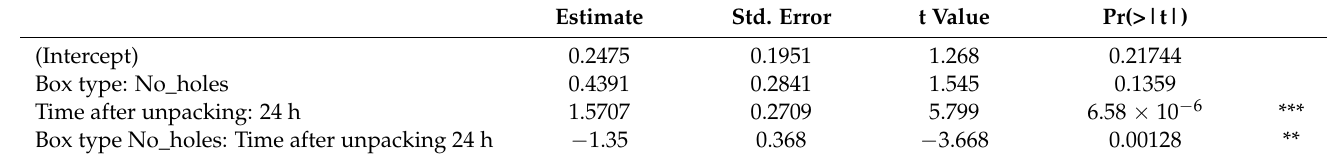
escape rate after long-distance